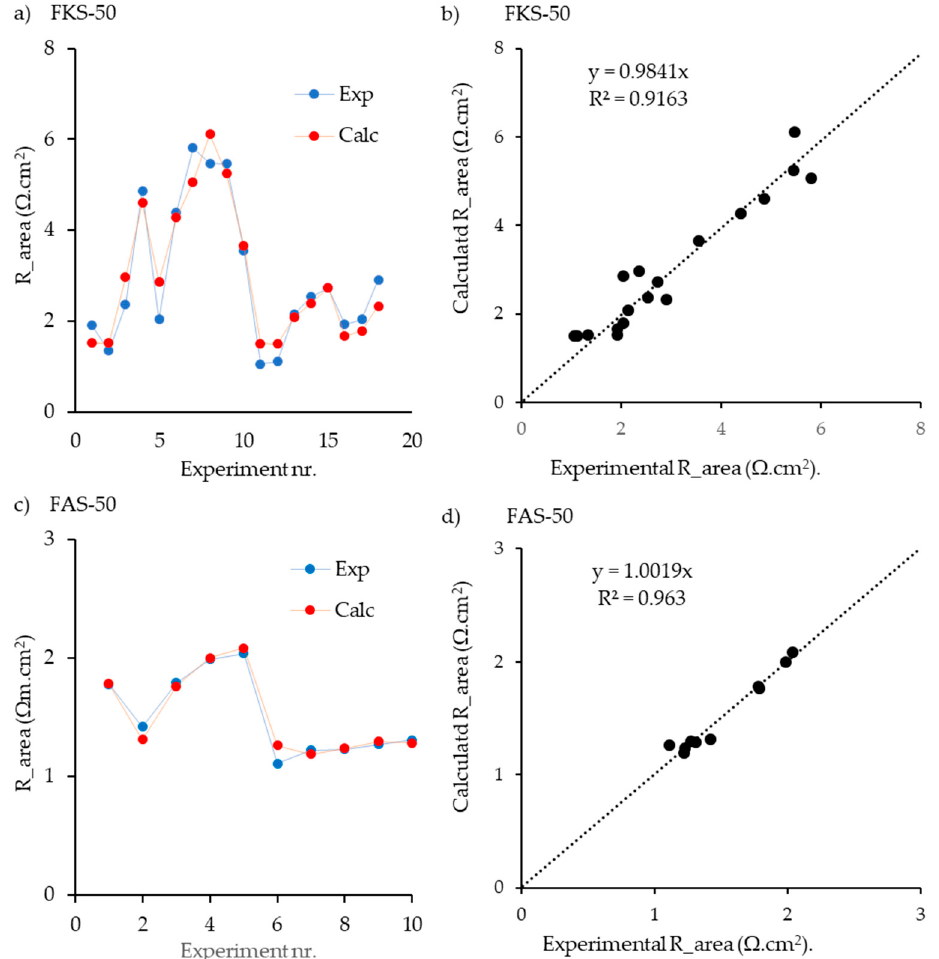
Figure 4. Results of the fitting procedure for the Fumatech membranes FKS-50 ( a , b ) and FAS-50 ( c , d ). Used were solutions containing NaCl, MgCl 2 , CaCl 2 , NaCl, and Na 2 SO 4 . Data are from G ό mez- ( c , d ). Used were solutions containing NaCl, MgCl 2 , CaCl 2 , NaCl, and Na 2 SO 4 . Data are from Coma et al. [22]. In ( a , c ), lines are added to guide the eye; in ( b , d ) the regression lines are shown. Gómez-Coma et al. [22]. In ( a , c ), lines are added to guide the eye; in ( b , d ) the regression lines are